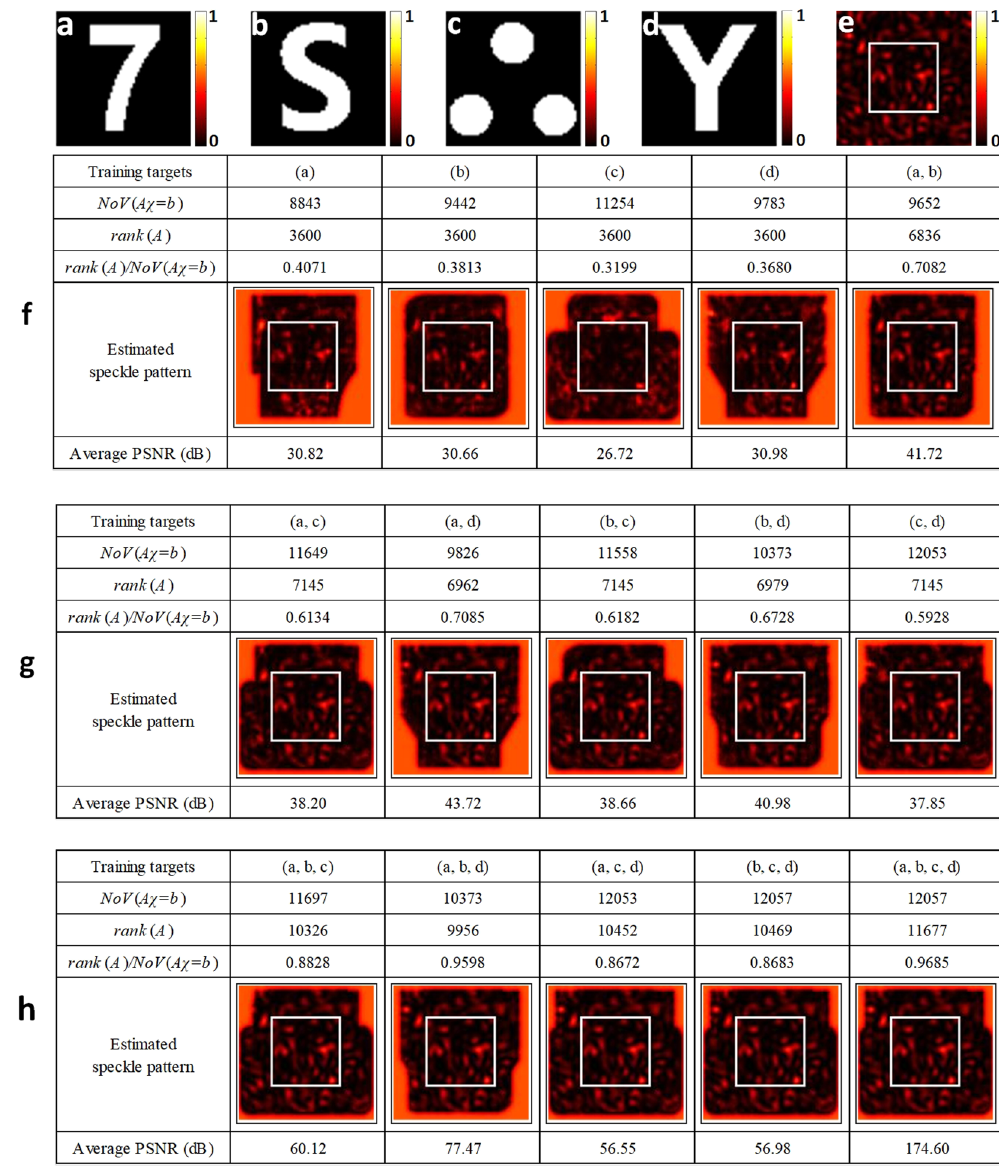
Figure 2. Simulated experiment for comparing the speckle pattern estimation performance. ( a – d ) Training targets in size of 60 ×